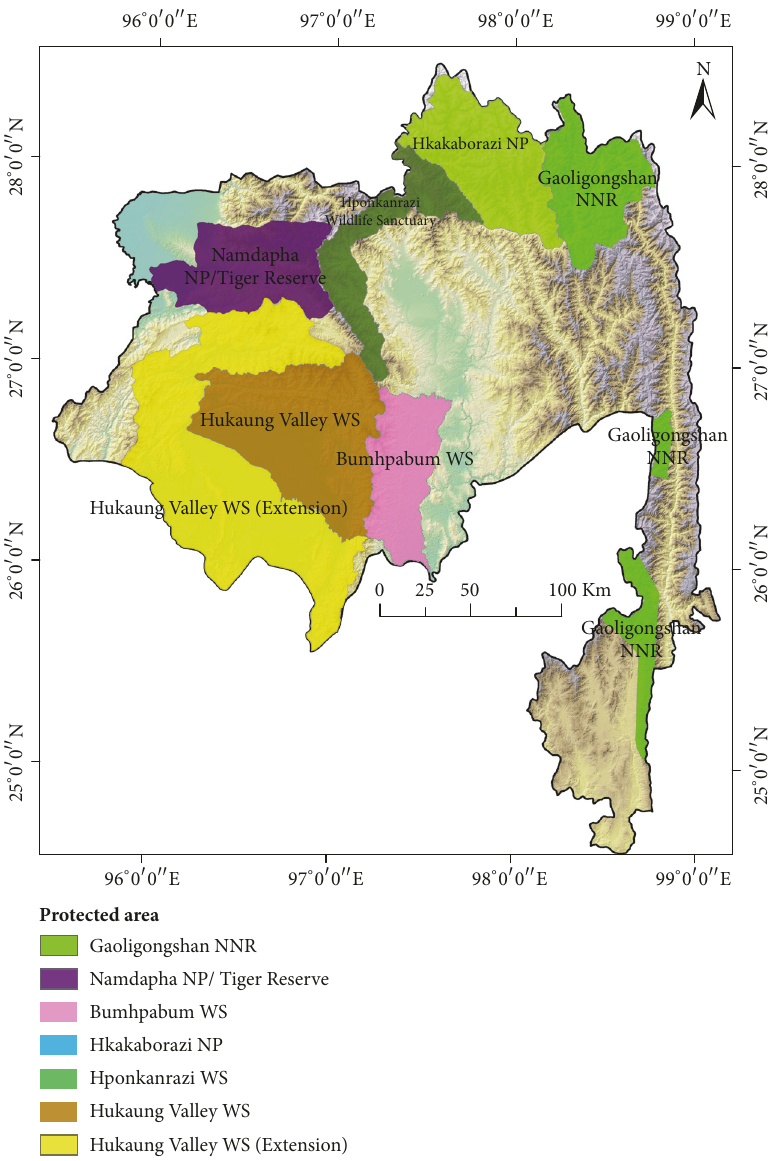
Figure 1: The Far-Eastern Himalayan Landscape showing protected